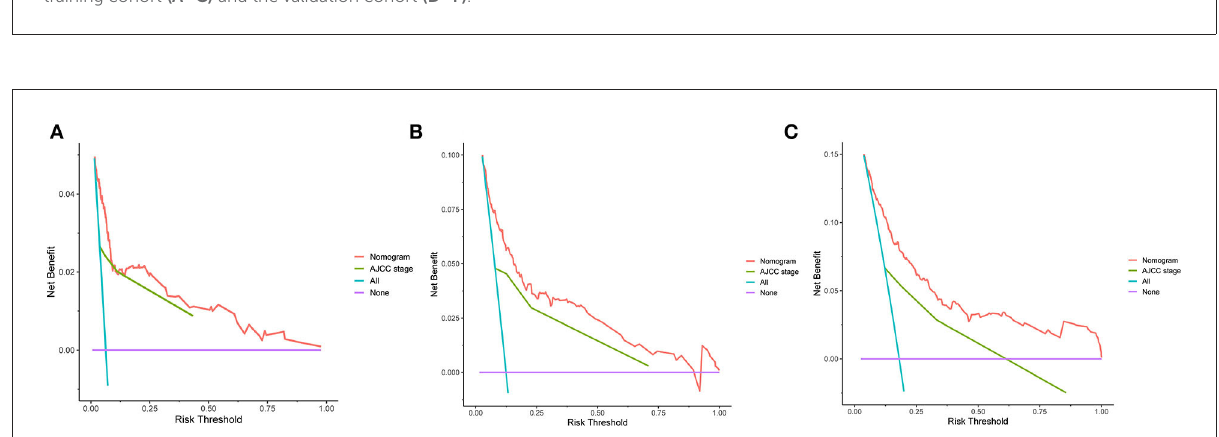
FIGURE4 Comparison of the prognostic value of the newly defined nomogram and the traditional AJCC staging by 1-, 3-, and 5-year ROC curves in the training cohort (A–C) and the validation cohort (D–F) .